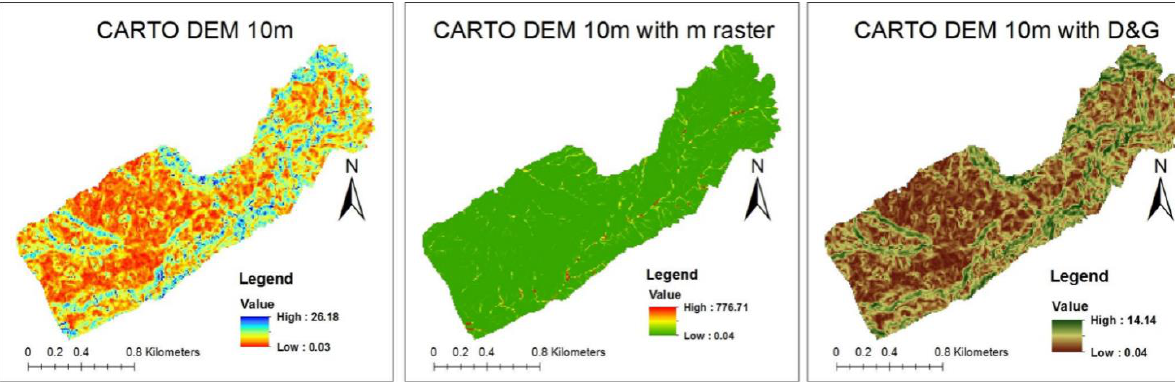
Figure 5: LS factor of CARTO DEM 10m with constant slope exponent, spatially distributed slope exponent and with multiple flow